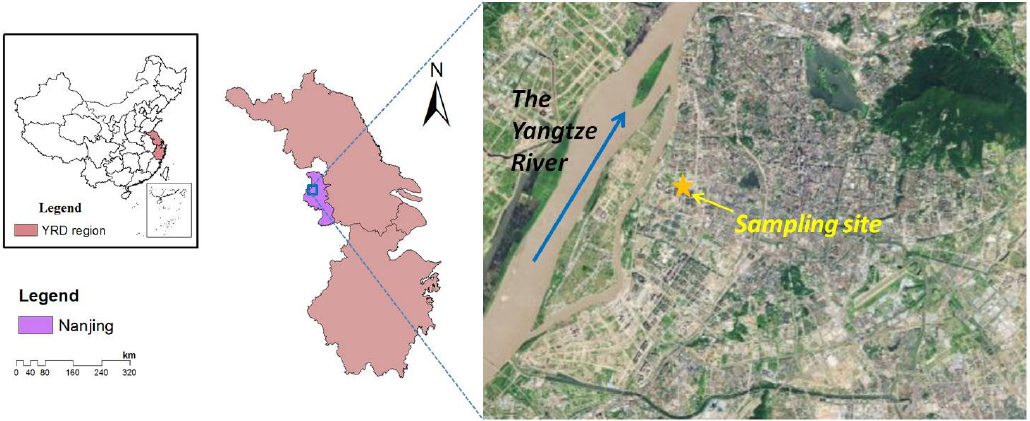
Figure 1. Sampling site of Nanjing.